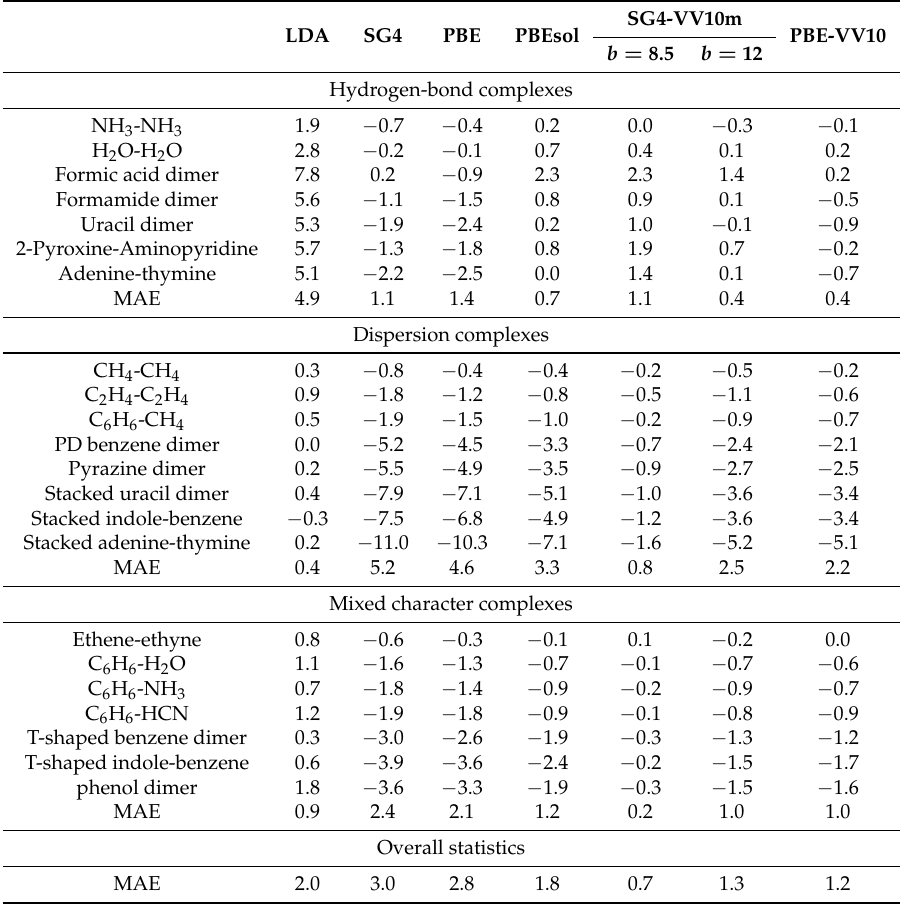
Figure 4. LDA, PBE, PBEsol, and SG4 xc enhancement factors F xc ( s , r s , ζ = 0 ) versus the reduced gradient s , for the spin-unpolarized case ( ζ = 0) and the bulk parameter r s = 10. Table 6. Errors (kcal/mol) of different functionals for the S22 test [76,77]. The last line of each panel reports the mean absolute error (MAE) for that set of